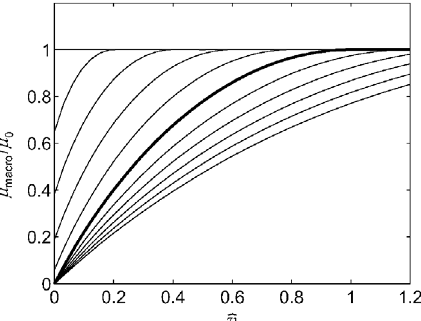
Fig. 8 Dependence of the normalized coefficient of friction on the normalized velocity v defined by Eq. (15) for the oscillation / 0, 0.2, 0.4, 0.6, 0.8, 1.0 amplitudes u u   (the bold line and ,0 z z all curves in the upper-left part) and for 1.8, 2.0 (bottom-right